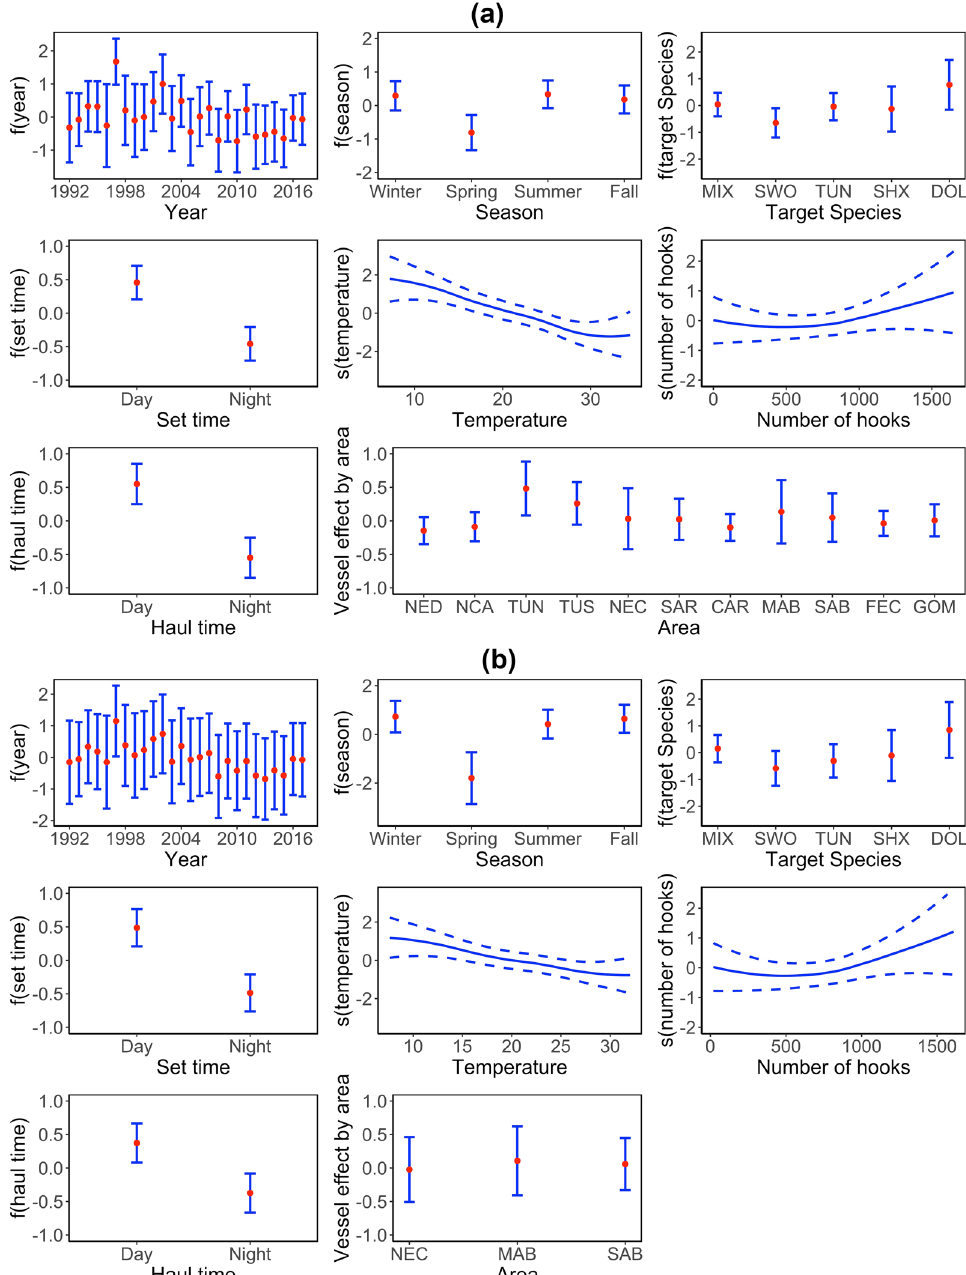
Figure 2. ( a ) Impacts of year, season, target species, set time and water temperature on logit( p ), impacts of number of hooks and haul time on ln(positive number of seabird bycatch per longline set), vessel effects on logit( p ) grouped by area from model M7 fitted with data from 11 fishing zones. ( b ) Impacts of year, season, target species, set time and water temperature on logit( p ) and impacts of number of hooks and haul time on ln(positive number of seabird bycatch per longline set), vessel effects on logit( p ) grouped by area from model T7 fitted to data from the three high-bycatch zones. Points and solid lines represent posterior mean values; error bars and dashed lines represent 95% credible intervals. For the area-average vessel effects, points represent area-specific mean of the posterior means and error bars represent standard deviations of the posterior means. Abbreviations of target species are as follow: MIX – Mixed species, SWO – Swordfish, TUN – Tuna, SHX – Shark, DOL – Dolphinfish. Abbreviations of fishing zones are as follow: NED – Northeast district, NCA – North Central Atlantic, TUN – Tuna North, TUS – Tuna South, NEC – Northeast coast, SAR – Sargasso region, CAR – Caribbean region, MAB – Mid-Atlantic bight, SAB – South Atlantic bight, FEC – Florida east coast, GOM – Gulf of Mexico. Plot is made using R package ggplot2 (version 3.3.2, https:// ggplo t2. tidyv erse. org) in statistical program R (version 3.6.3, http:// www.R- proje ct.